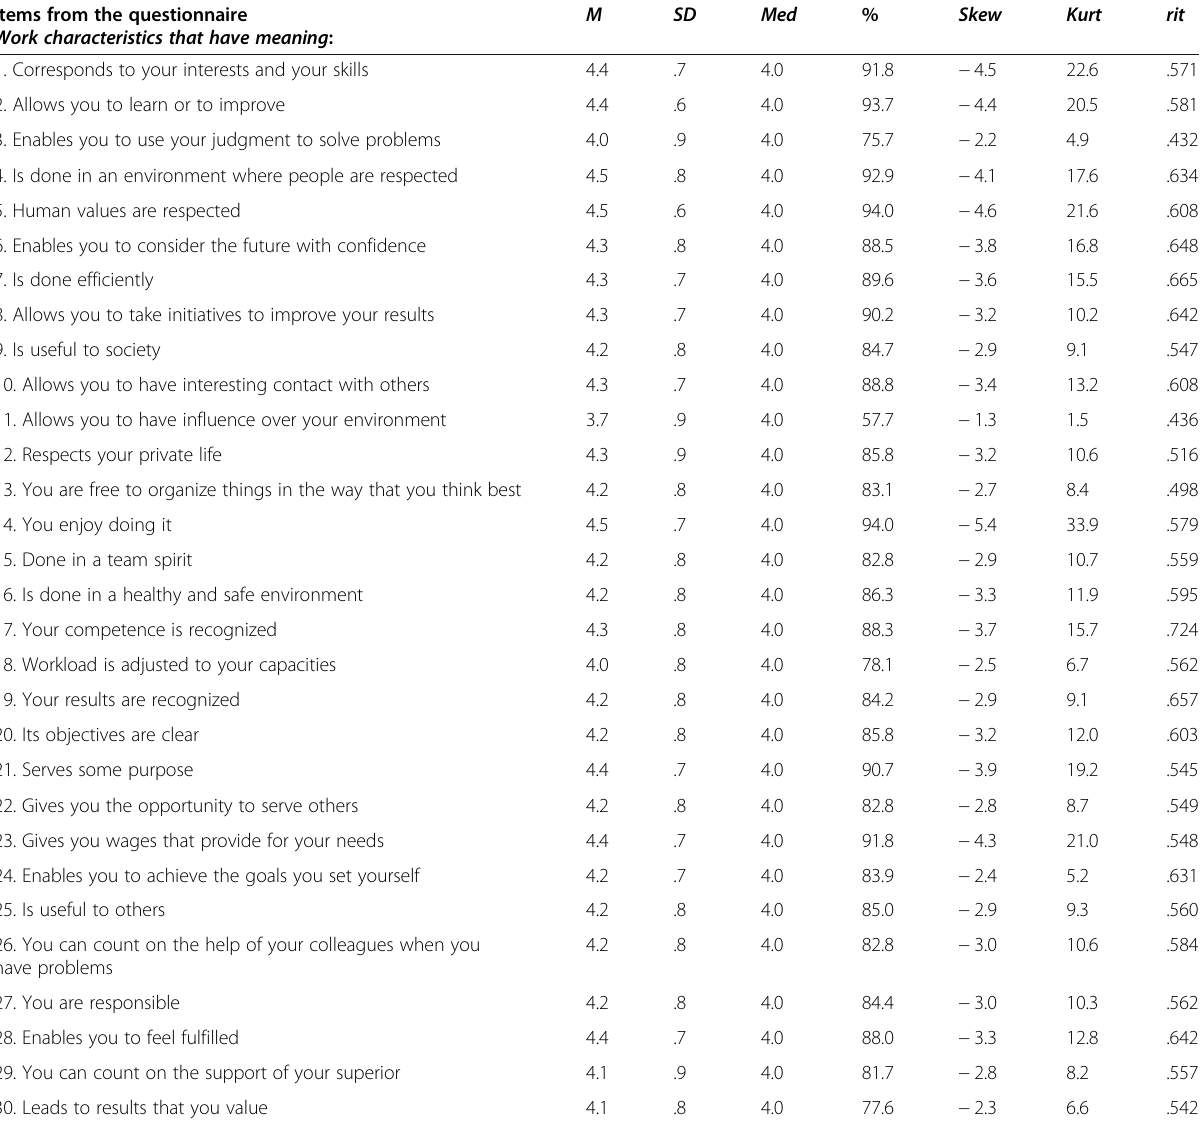
Table 4 Distribution and analysis of the 30 items of the scale Items from the questionnaire Work characteristics that have meaning